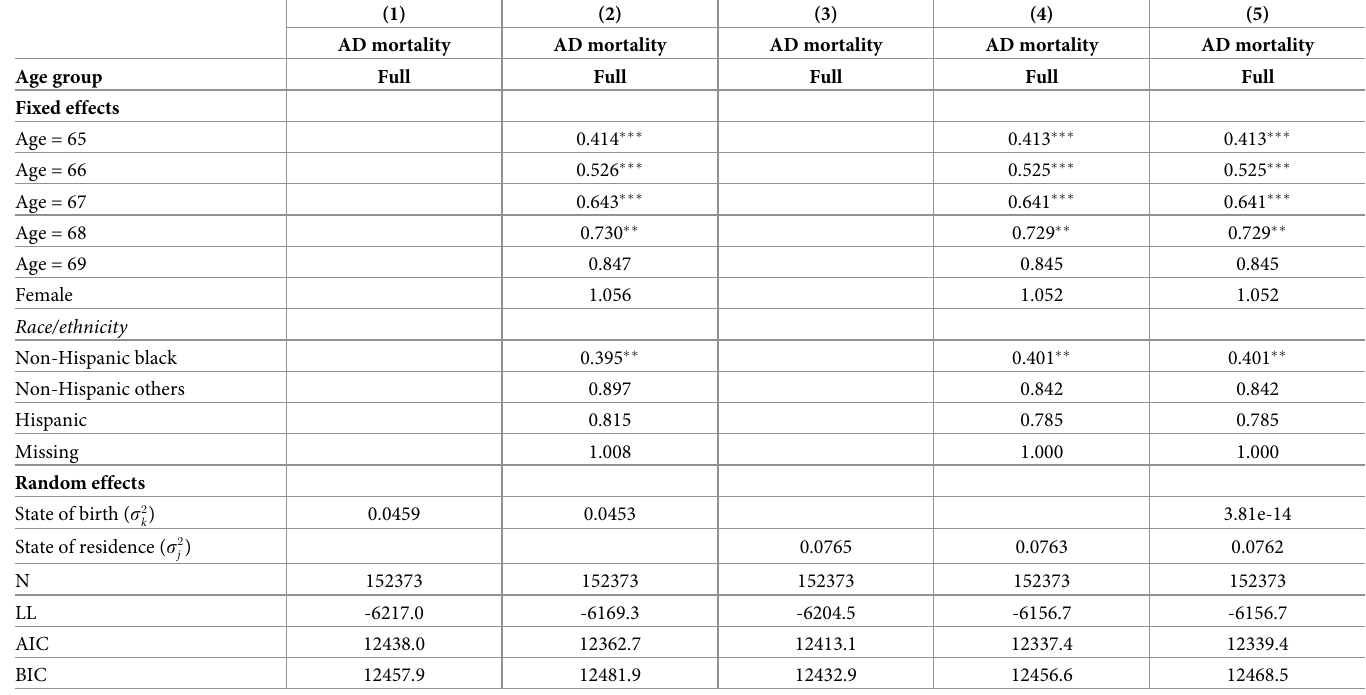
for all-cause mortality using alternative data. Regarding the fixed effects, ages 65 through 68 are statistically significant across all models they are included in (models 2, 4, and 5). Mean- while, for race/ethnicity, it shows that non-Hispanic blacks are significant across all models, whereas other racial groups are not. Models 3 and 4 then show that state of residence accounts Table 3. Results of multilevel logistic regression